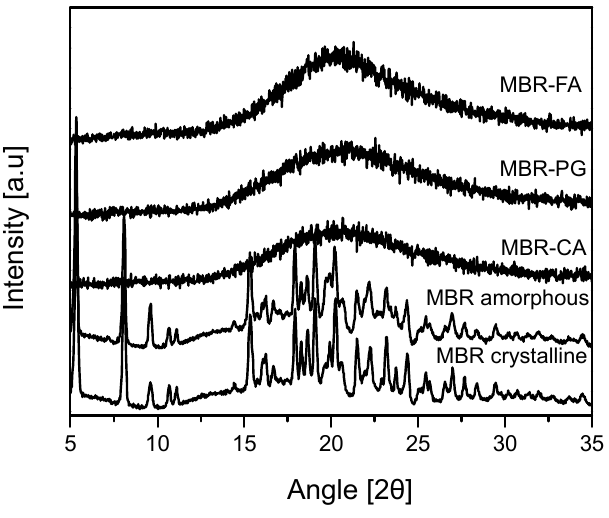
Figure 7. PXRD of MBR solids collected after 12 h of dissolution test.